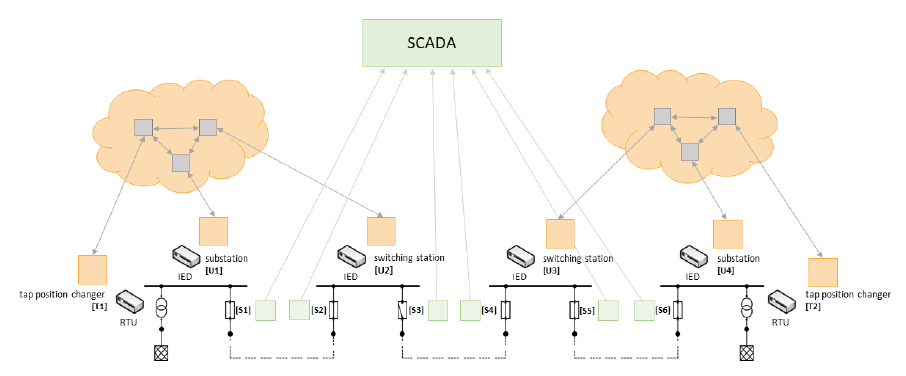
Figure 6. Example medium voltage grid. T i are tap position changing transformers, S i are circuit breakers and U i are metering